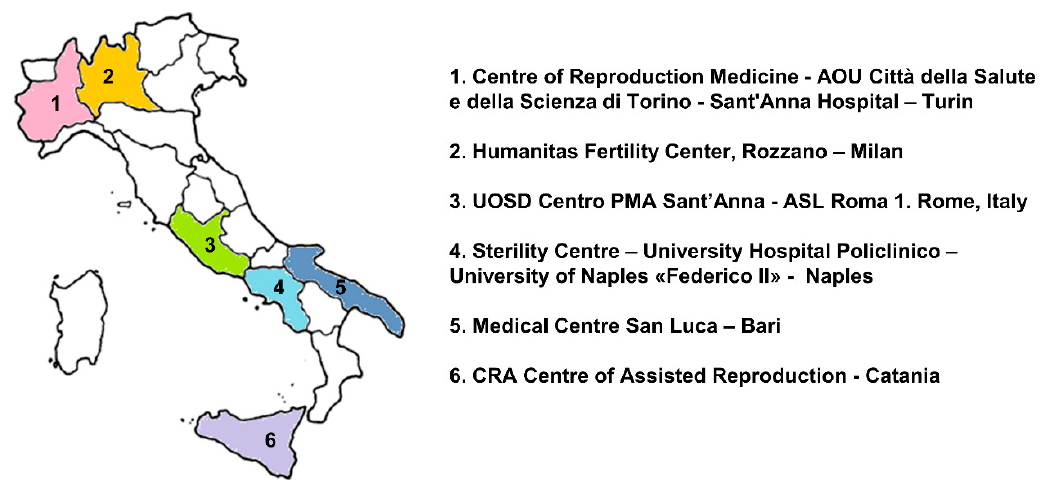
Figure 1. Recruiting